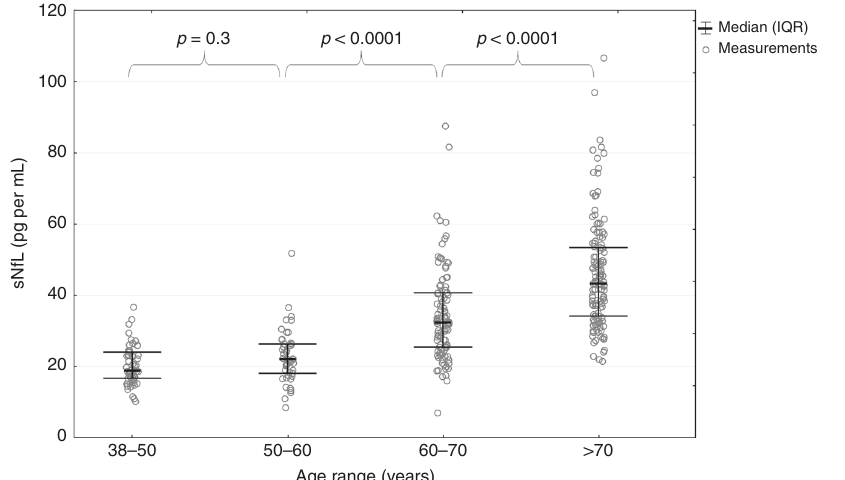
Fig. 3 Variance of sNfL per age groups. Variance analysis: original sNfL values for each age category. The p values result from the Brown − Forsythe test, which analyzes the equality of the variance in two adjacent age categories. While the variance in the fi rst two categories can be considered as equal, it is increased signi fi cantly in the age categories> 60 years. Source data are provided as a Source Data fi le.